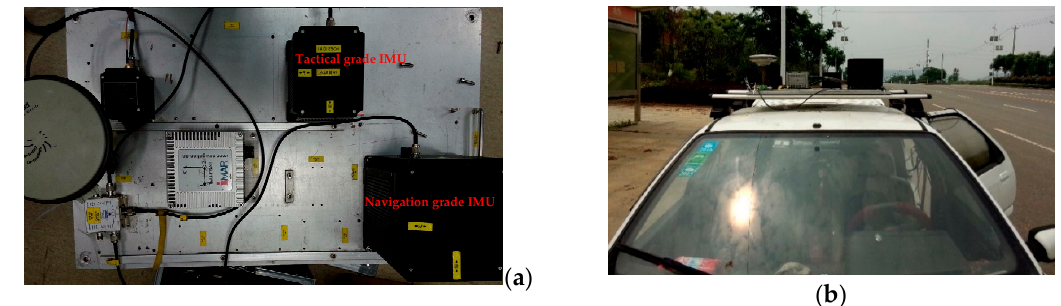
Figure 3. IMUs and GPS/BDS antenna ( a ) used in the test and their locations on the land-borne vehicle ( b ).